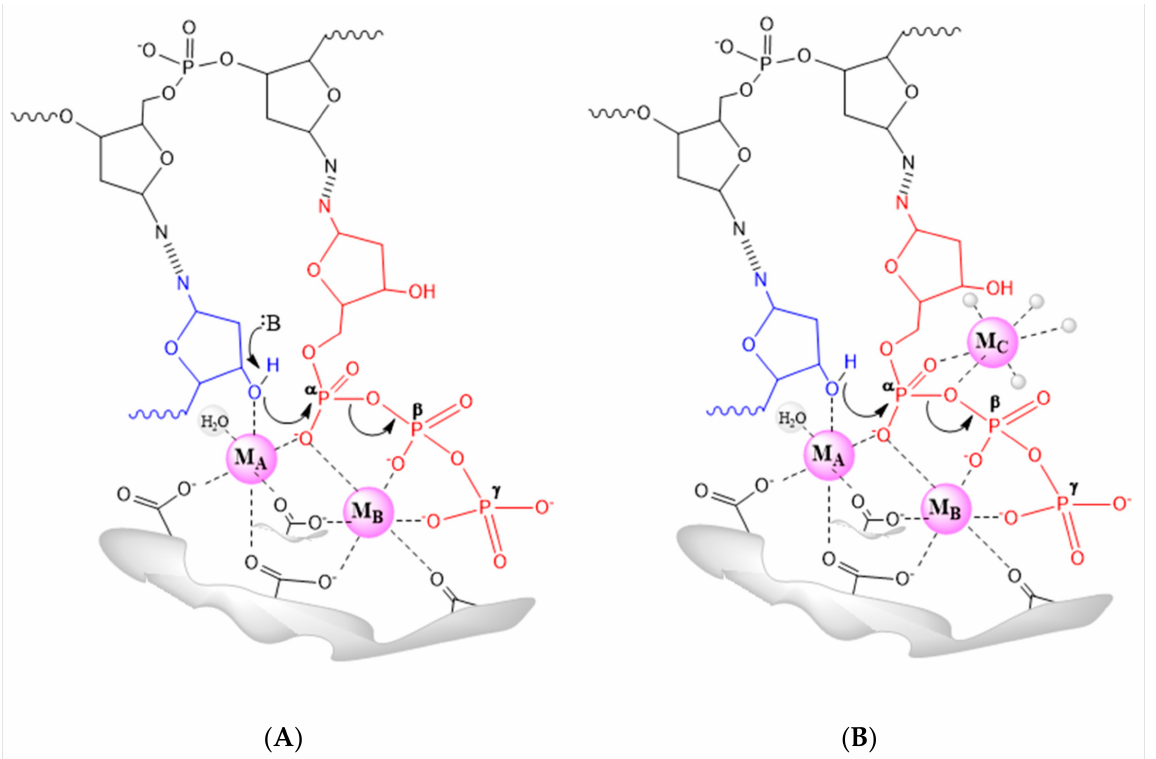
Figure 1. The proposed two-metal-ion mechanism ( A ) and three-metal-ion mechanism ( B ). The incoming nucleotide is colored red, template and primer DNA are colored black and blue, respectively, enzyme moieties are colored grey, metal ions are